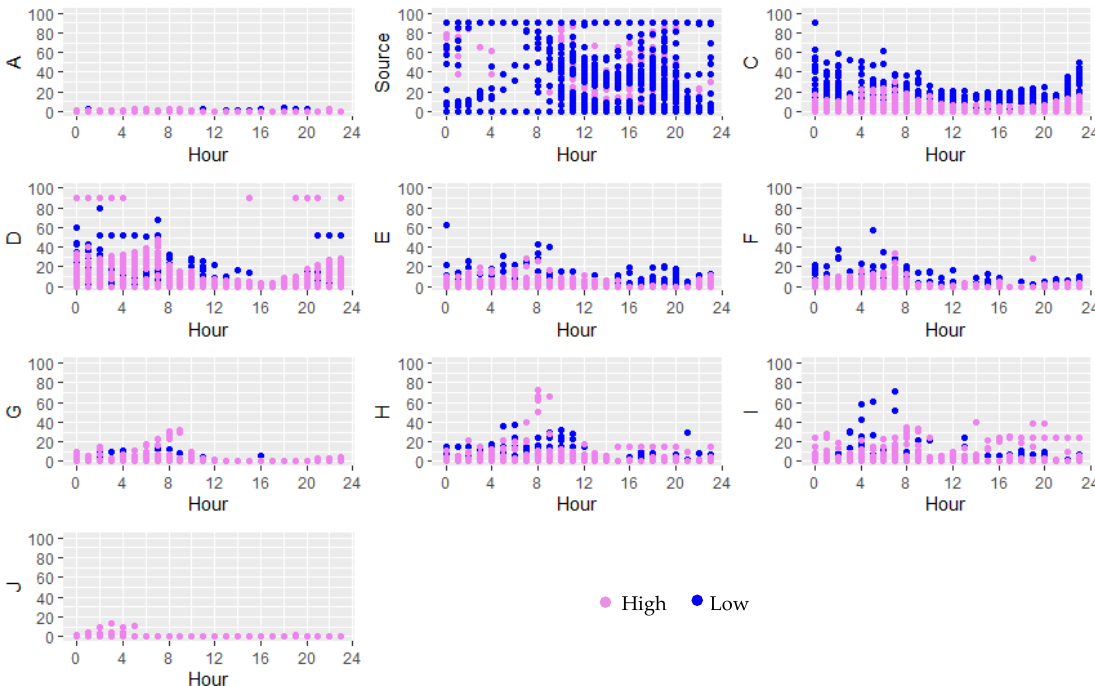
Figure 8. Hydrogen sulfide concentration (ppb) measurements based on time of day during the monitoring period (when the wind was in the direction of the downwind sensors—29% of the total monitored period) for the swine case study at monitoring locations A (upwind of barns), Source ( B ), and C – J (increasing downwind distance from barns). High and low points are indicative of the concentration data collected by the monitors at 5.5 m and 1 m heights, respectively.